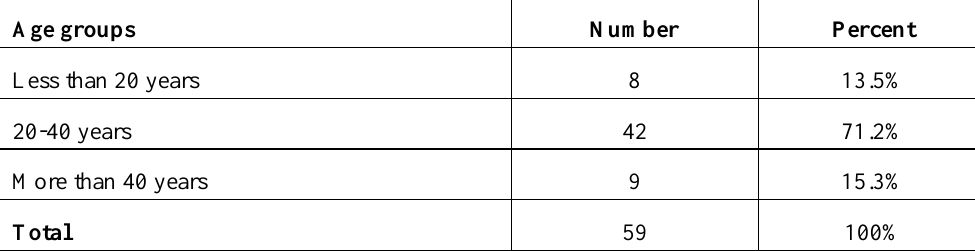
Table 1. Distribution of study sample according to age